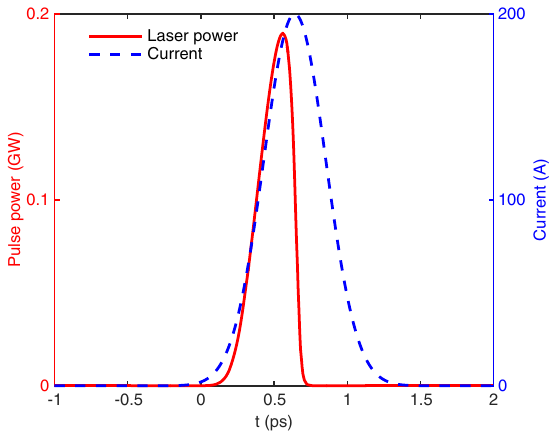
FIG. 7. The laser profile at 0 . 6 λ cavity desynchronism.